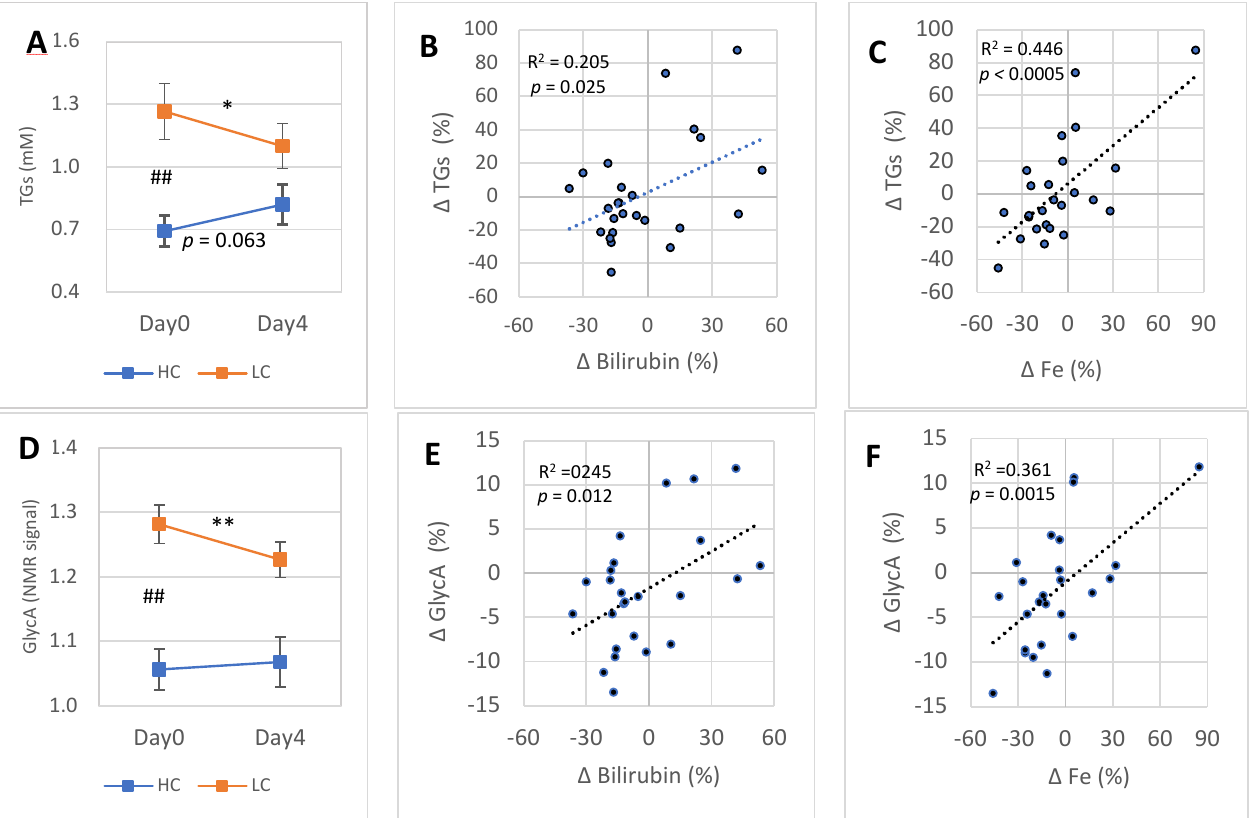
Figure 5. 4-day DGA regimen activates the LC subgroup: ( A ) mean (±SEM) blood TGs in the HC and LC subgroups separately, ( B , C ) cross correlation between intra-individual four-day percent changes of TGs (vertical scale) and ( B ) blood bilirubin (horizontal scale) and ( C ) blood Fe (horizontal scale) in the whole group. ( D ) Mean (±SEM) blood GlycA in the HC and LC subgroups separately. ( E,F ) Cross correlation between intraindividual four-day percent changes of GlycA (vertical scale) and € blood bilirubin (horizontal scale) and ( F ) blood Fe (horizontal scale) in the whole group. Notes: * and ** indicate paired t -test from Day0 to Day4, # indicates non-paired t -test between the TGs and GlycA concentrations on Day0. In ( B , C ) and ( E , F ), the p -values are based on an F-test.